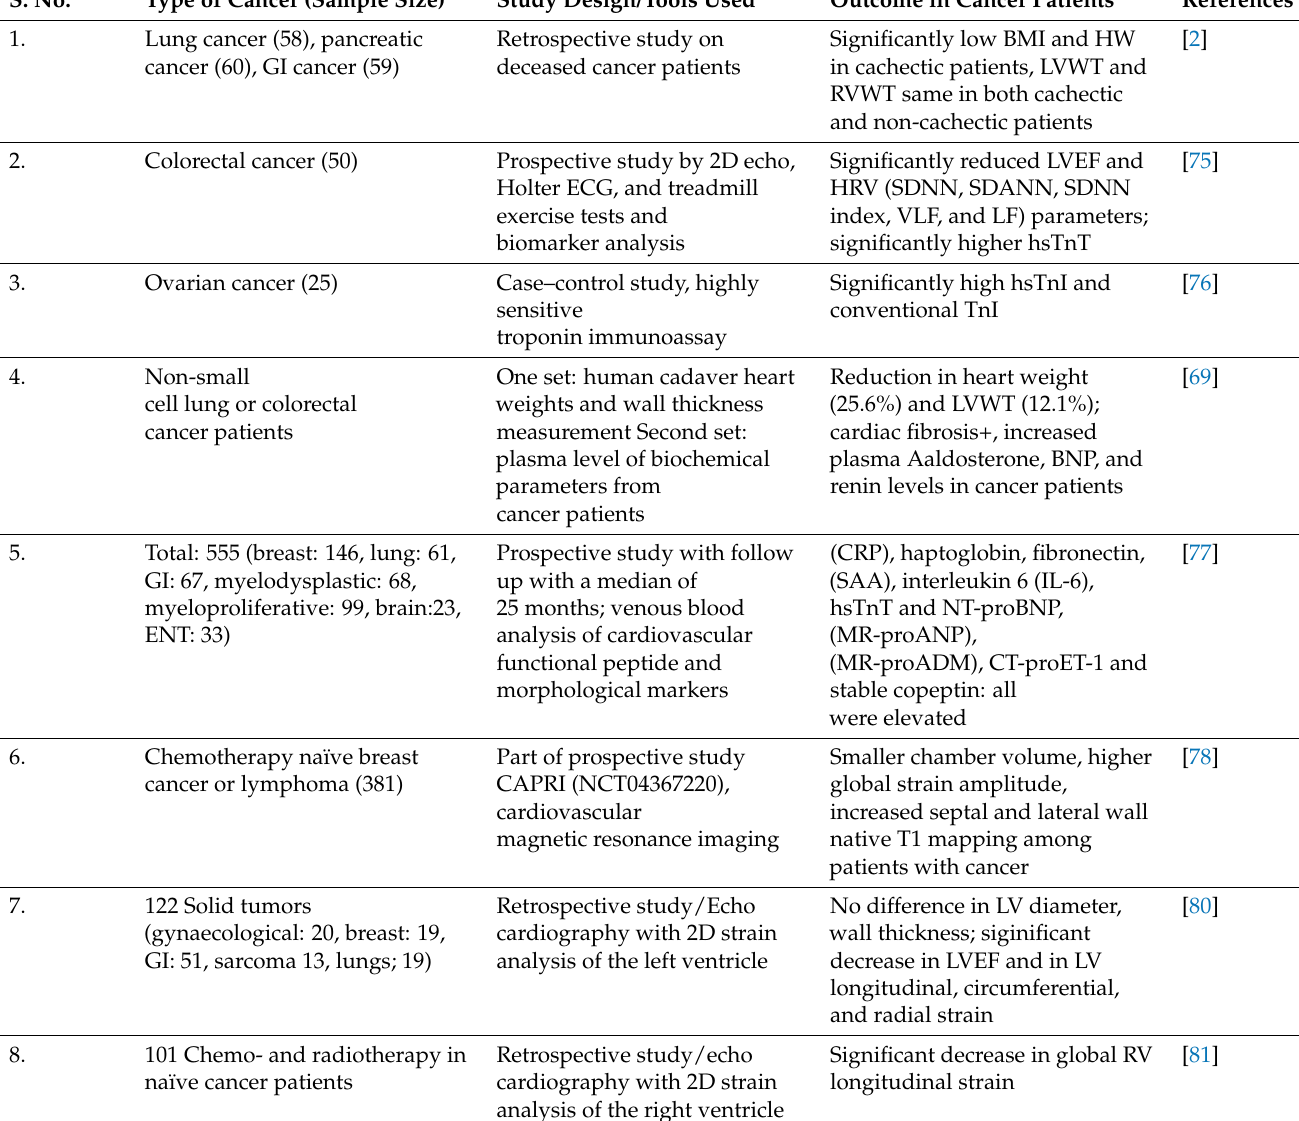
Table 2. Clinical studies on evidence of cancer-induced cardiac